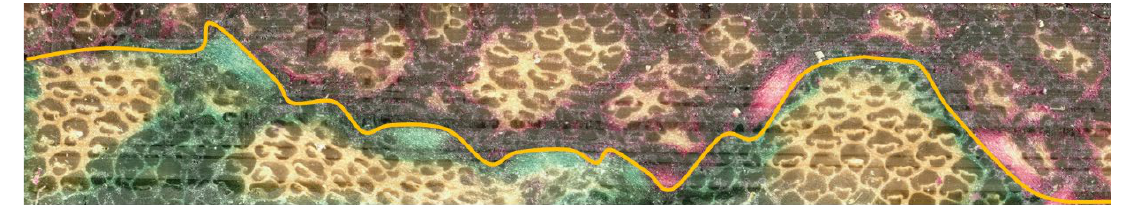
Figure 3. The comb-meshing structure of the macro bonding interface.